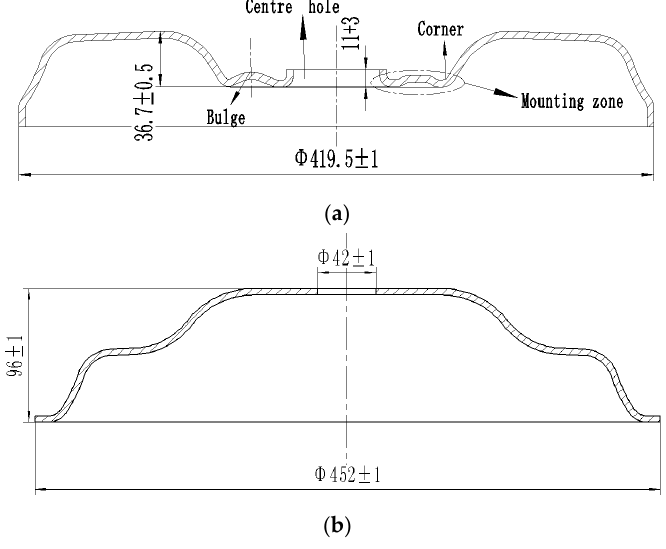
Figure 2. Formed part and blank in a reverse drawing–flanging combined spoke process: ( a ) Formed part of reverse drawing–flanging combined process; ( b ) Blank of the reverse drawing–flanging combined process.